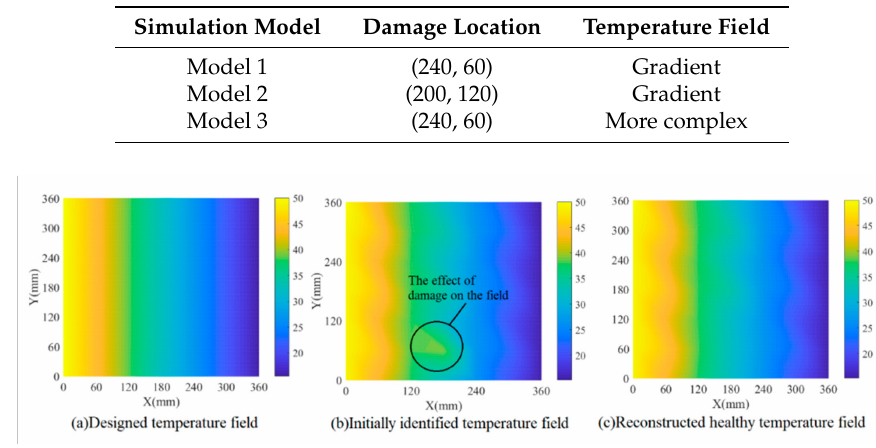
Table 2. Damage cases in the simulation.